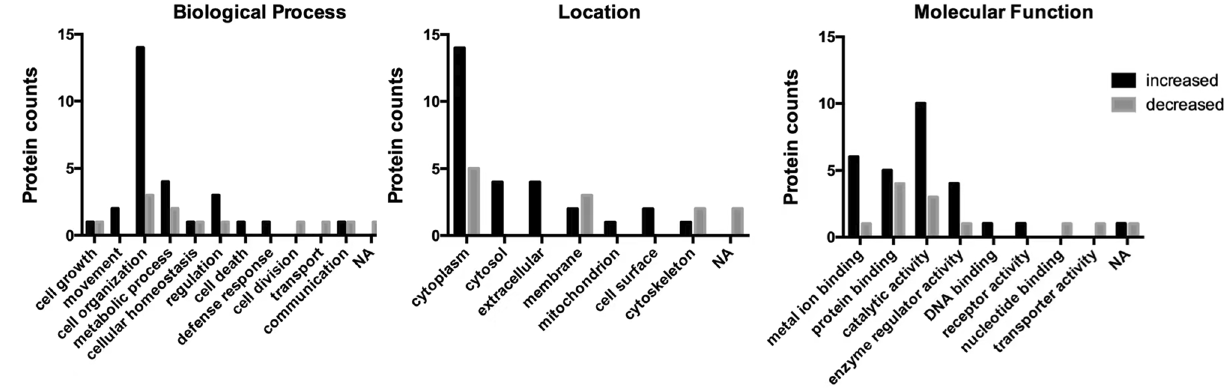
Figure 2. The characteristics of different extraocular muscles proteins in craniosynostosis group.